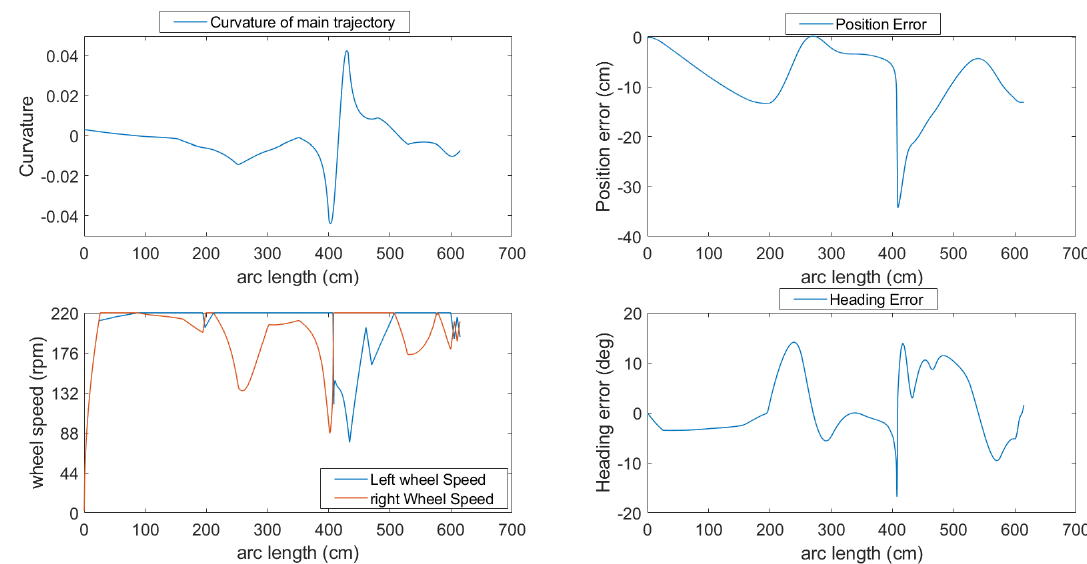
Figure 21. Left and right wheel angular speed, position error and heading error of the robot’s pose, with respect to desired pose on trajectory of the first scenario.